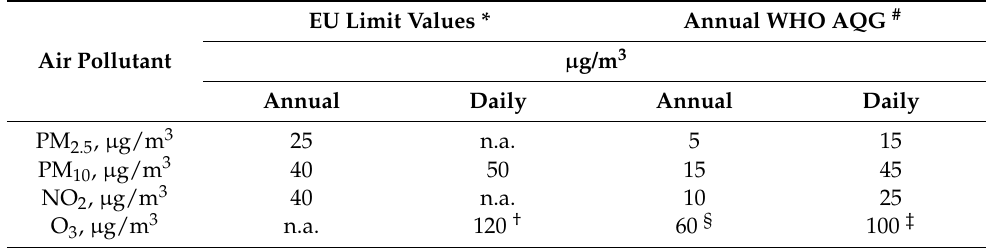
Table 2. EU limit values and WHO Air Quality Guidelines (AQG) for considered air